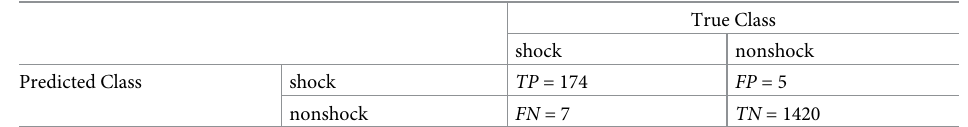
Table 2. Confusion matrix.